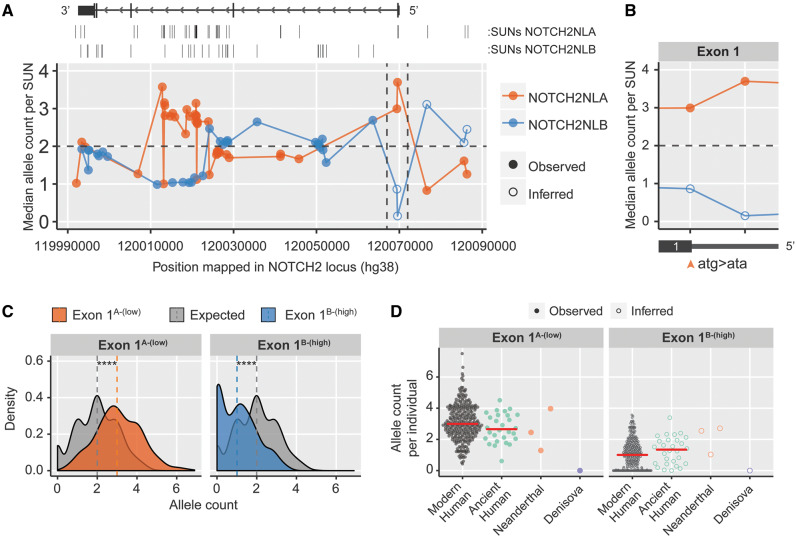
Exon1 variant frequencies in modern human and ancient genomes. (A) Median allele count for each of the NOTCH2NLA- and NOTCH2NLB-specific SUNs along the NOTCH2NL locus in Simons diversity genomes (N = 279). (B) Zoomed in region of Exon1, orange arrowhead indicates Exon1B-(High) (ATG)/Exon1A-(Low) (ATA) variant positions. (C) Distribution of Exon1A-(Low) and Exon1B-(High) (inferred) variants in Simons diversity genomes. Expected distribution models equal frequency of both variants. Vertical dashed lines indicate medians. N = 279, Kolmogorov–Smirnov test: P < 2e-16. (D) Analysis of Exon1A-(Low) and Exon1B-(High) (inferred) variant frequency in modern humans and archaic genomes. Red lines indicate medians.